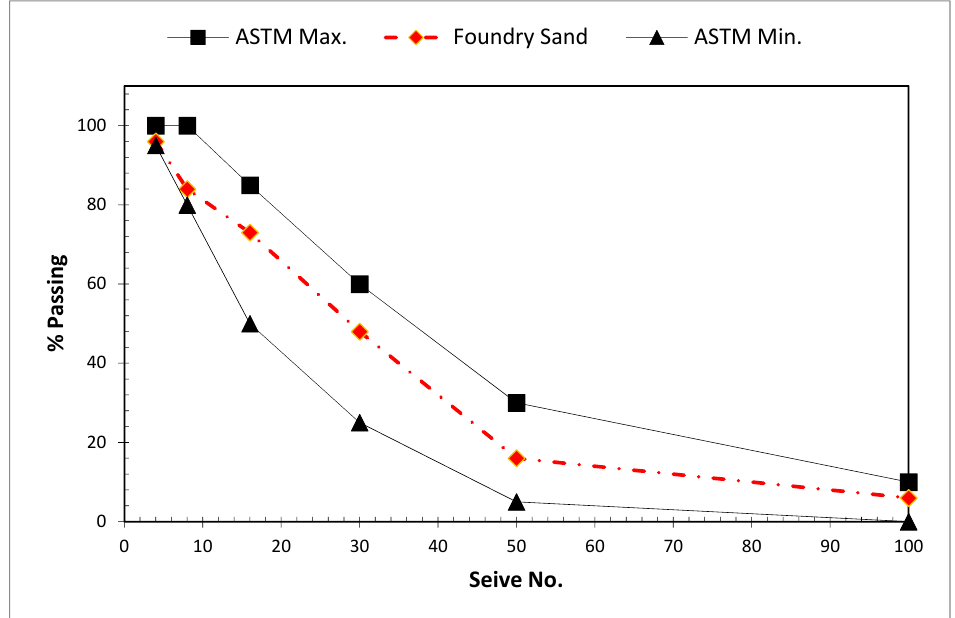
Figure 2. Particle Size Distribution of WFS [39].